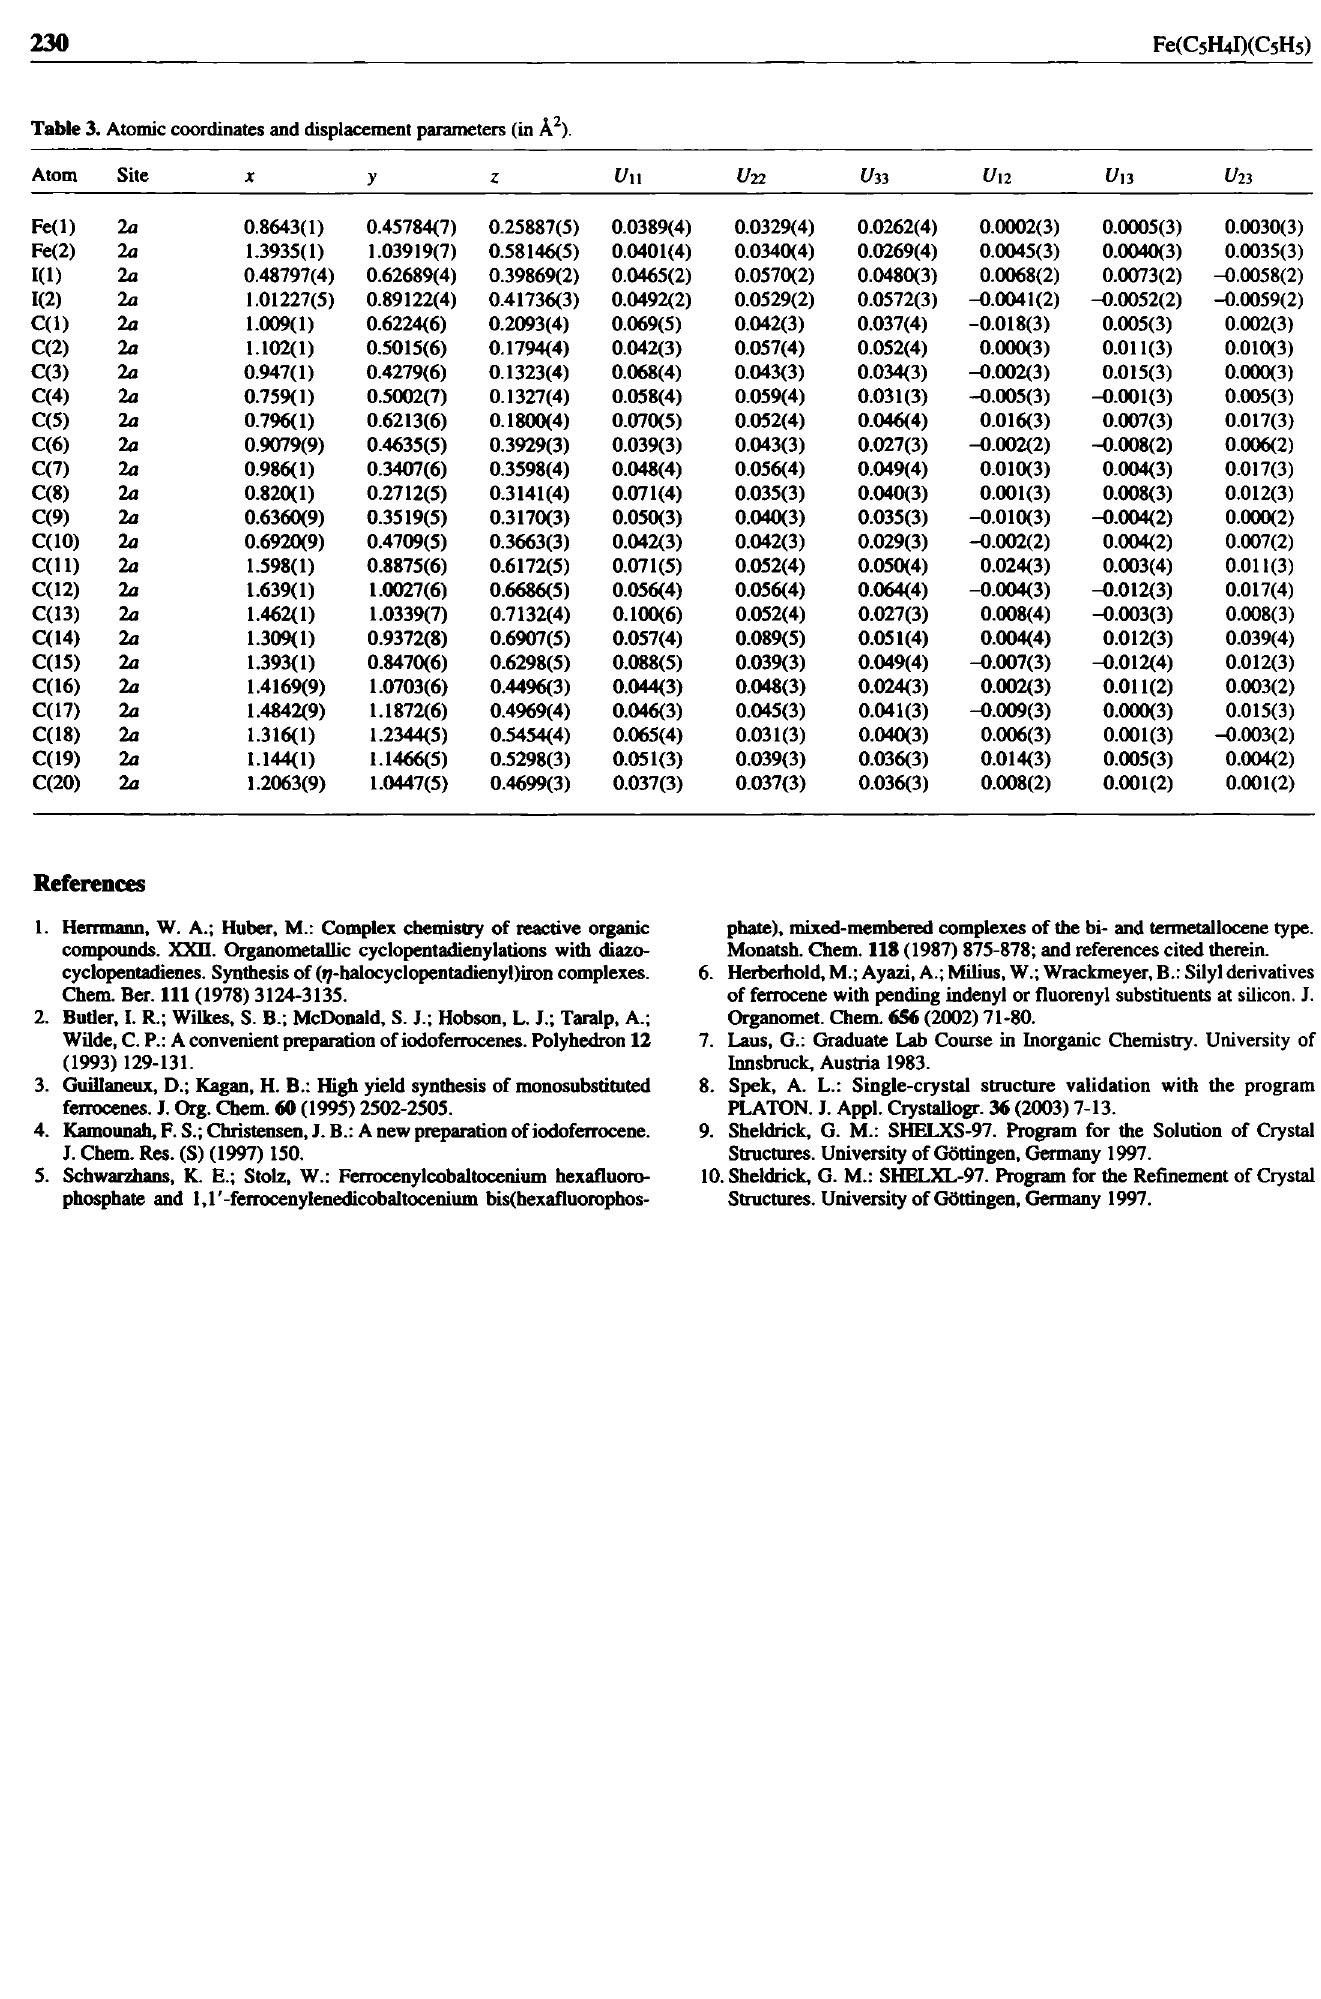
Table 3. Atomic coordinates and displacement parameters (in Ä 2